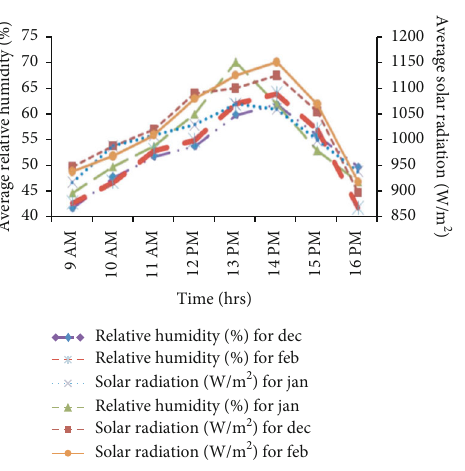
Solar radiation (W/m 2 ) for dec Solar radiation (W/m 2 ) for feb Figure 16: Performance characteristics curve on SPV module with the e ff ect of relative humidity